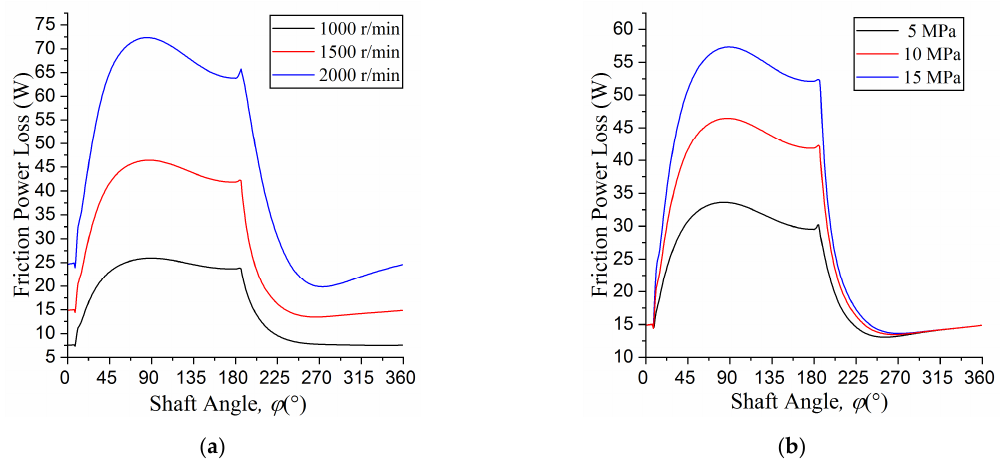
Figure 20. Simulation results of friction power loss of the slipper/swashplate interface. ( a ) Under the working pressure of 10 MPa. ( b ) Under the shaft speed of 1500